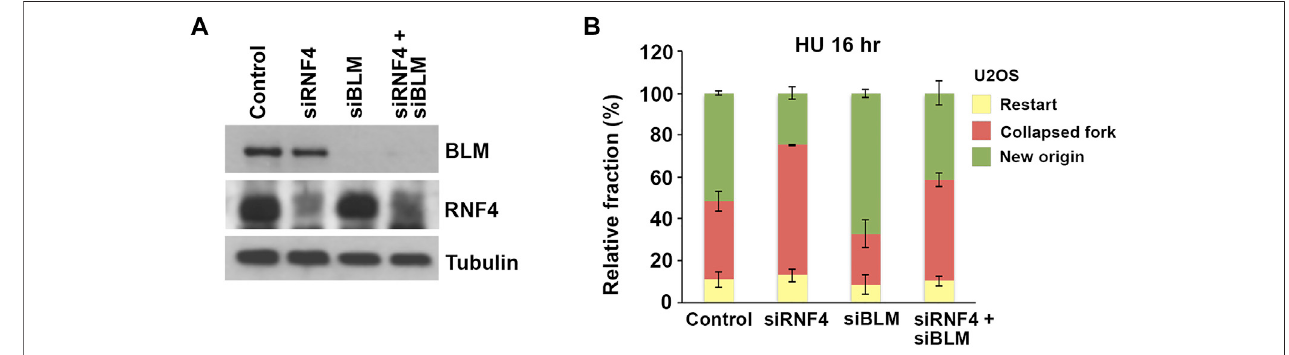
FIGURE6| BLM depletion rescued effects ofRNF4depletion onDNA replication stressresponses. (A) Immunoblot analysisofU2OS cell lysates following siRNA- mediateddepletionofRNF4, BLM, orBLM togetherwithRNF4. (B) Quantitative analysisofreplicationrestart inU2OScontrol,RNF4-depleted, BLM-depleted,or RNF4 and BLM co-depleted cells after release from 16-h 2 mM HU treatments. Results from three independent experiments with standard deviations are